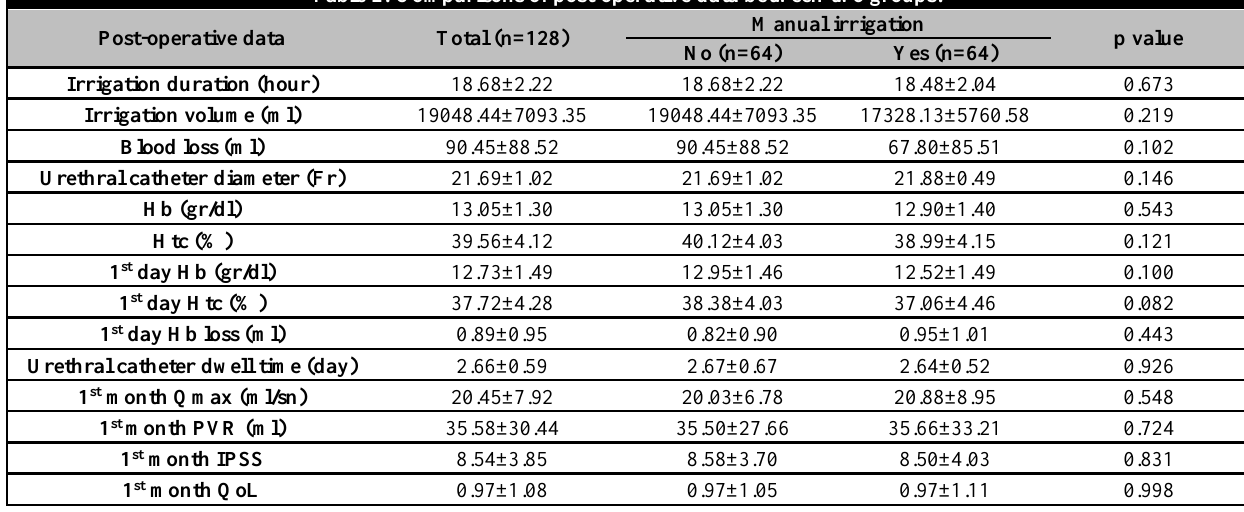
Table 2: Comparisons of post-operative data between two